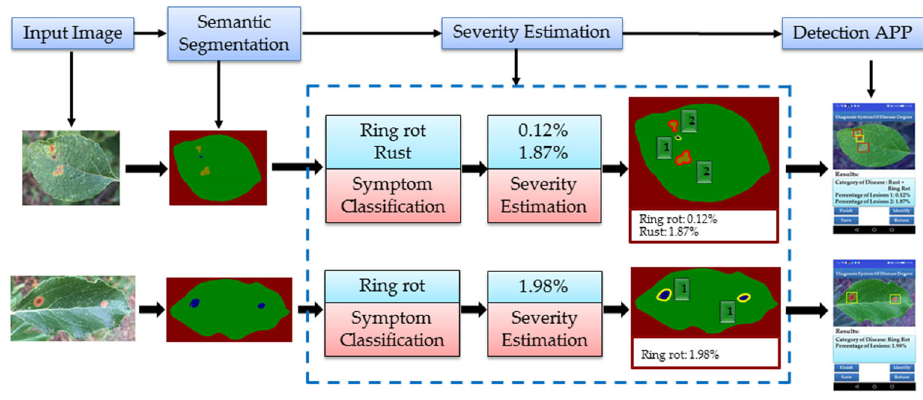
Figure 6. Research